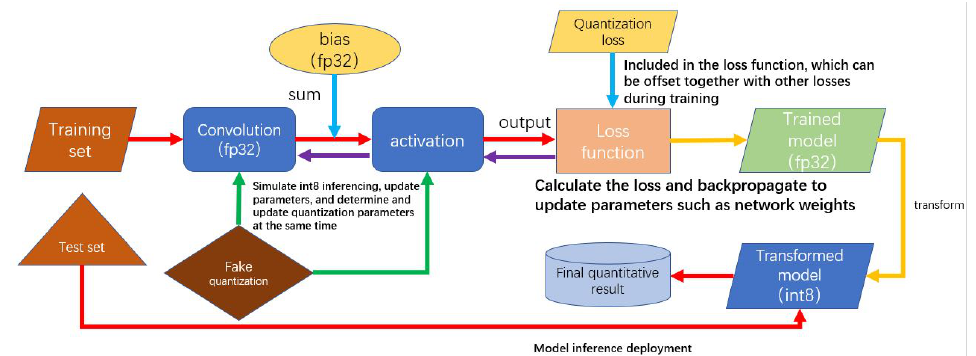
Figure 5. Quantization aware training